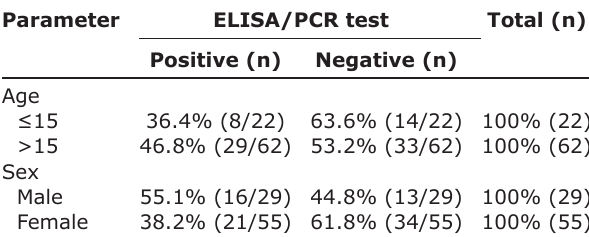
Table-2: EEHV test using blood samples in healthy elephants with no record of EEHV (n=84). Parameter ELISA/PCR